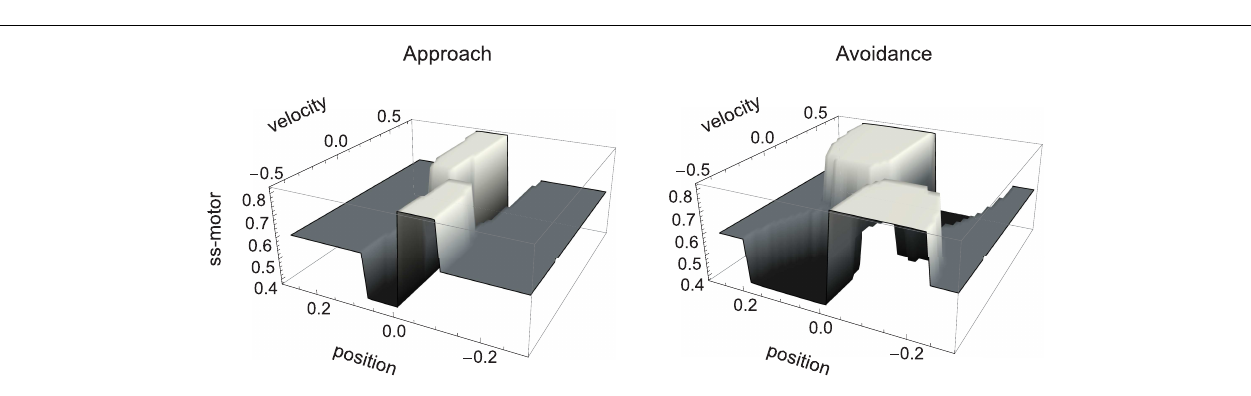
FIGUREA4 |Attractor landscape of evolved agent in approach and avoidance conditions . Steady-state motor output as a function of fixed sensory input resulting from a motor command (velocity) at a